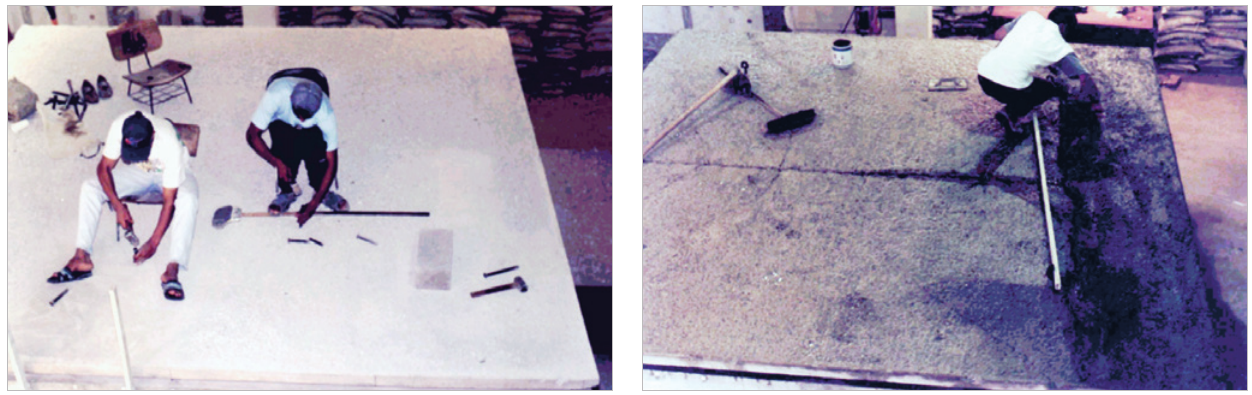
The manual chipping on the upper surface and the spreading of the strengthen layer